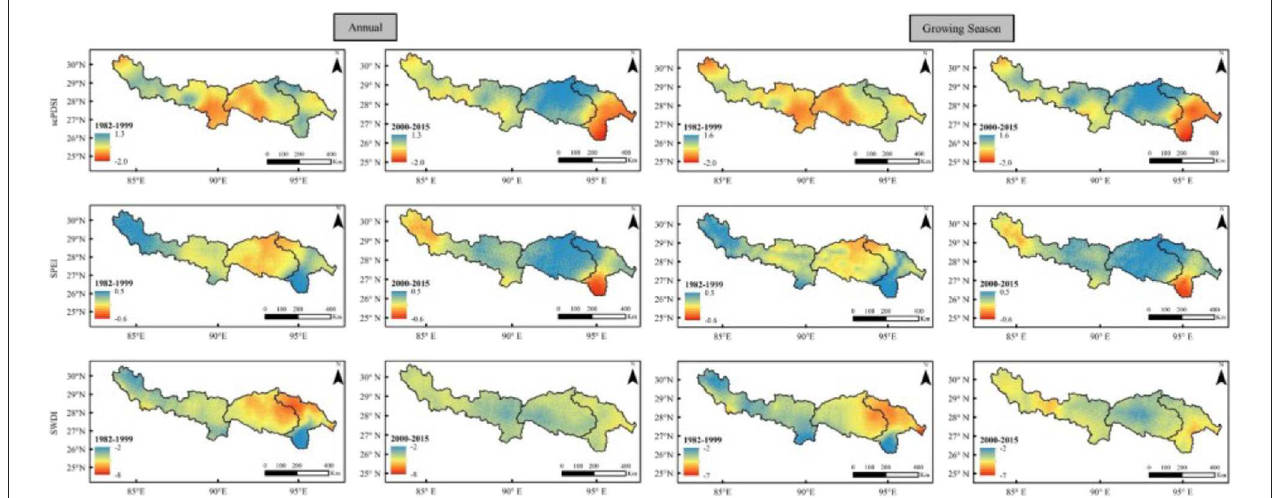
FIGURE 4 | Annual and growing season spatial distributions of three drought indices.